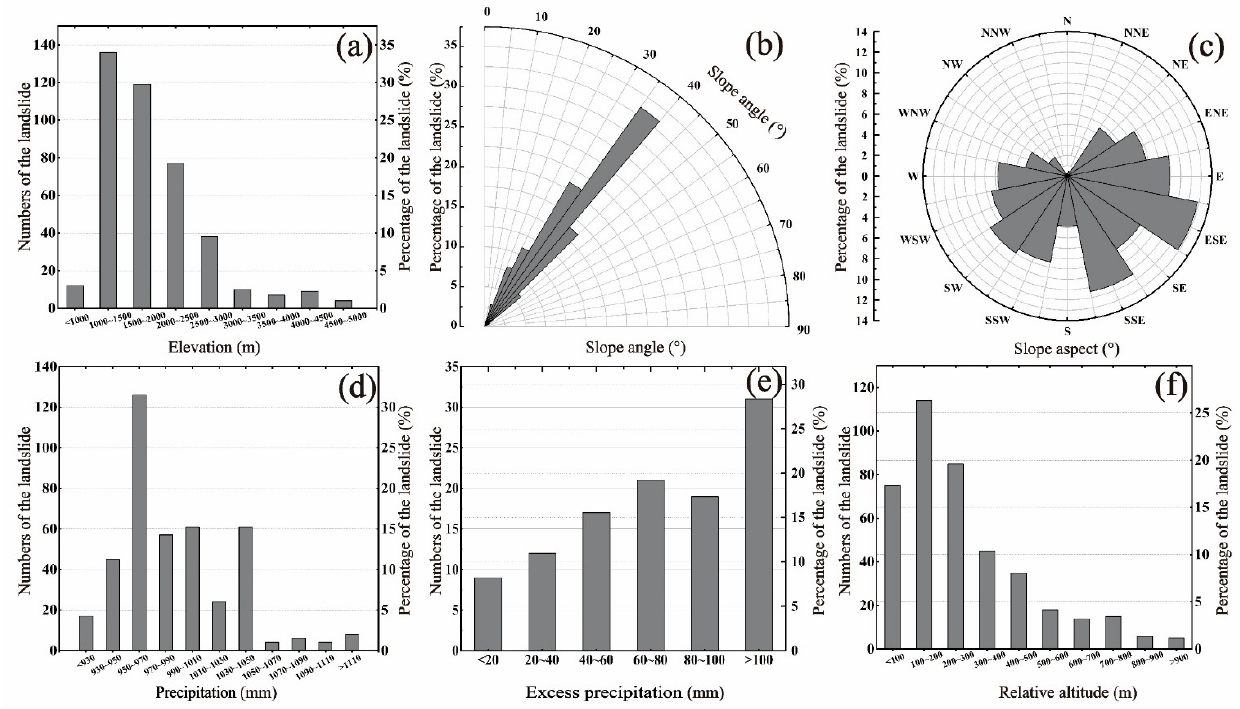
Figure 13. Relationships between distribution of detected landslides and elevation, slope angle, slope aspect, precipitation, excess precipitation, and relative altitude, respectively: ( a ) relationship between distribution of detected landslides and elevation; ( b ) relationship between distribution of detected landslides and slope angle; ( c ) relationship between distribution of detected landslides and slope aspect; ( d ) relationship between distribution of detected landslides and precipitation; ( e ) relationship between distribution of detected landslides and excess precipitation, and ( f ) relationship between distribution of detected landslides and relative altitude.